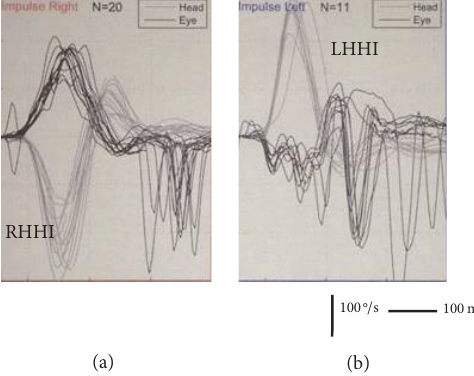
Figure 2: Case 2 . Video head impulse test of the patient. (a) Rightward head impulses in the plane of the horizontal canal (RHHI) induce a correct response in terms of the gain of the VOR; fast eye movements in the contrary direction of the eye after the reflexive eye movement are seen as part of the spontaneous nystagmus and imbalanced vestibular nuclei function in the acute stage.(b)Leftwardheadimpulsesintheplaneofthehorizontalcanal (LHHI) do not evoke a correct eye response; gain is very low and is followed by refixation saccades mixed with the fast phases of the spontaneous nystagmus.